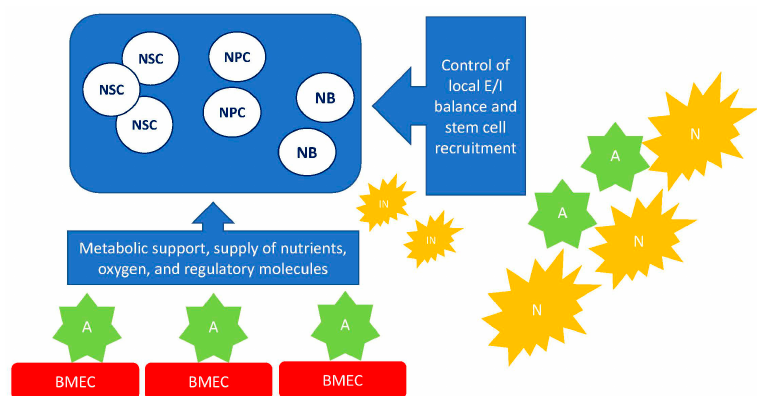
Figure 1. A simplified scheme of intercellular communications within the neurogenic niche. The local microenvironment is established due to the activity of neuronal, astroglial, and endothelial cells that are able to release various molecules (growth factors, neurotransmitters, cytokines, gliotransmitters, metabolites) affecting cell fate within the niche . Abbreviations used : NSC—neural stem cell, NPC—neural progenitor cell, NB—neuroblast, IN—immature neuron, N—neuron, A—astrocyte, BMEC—brain microvessel endothelial cell, E/I—excitation-inhibition balance.